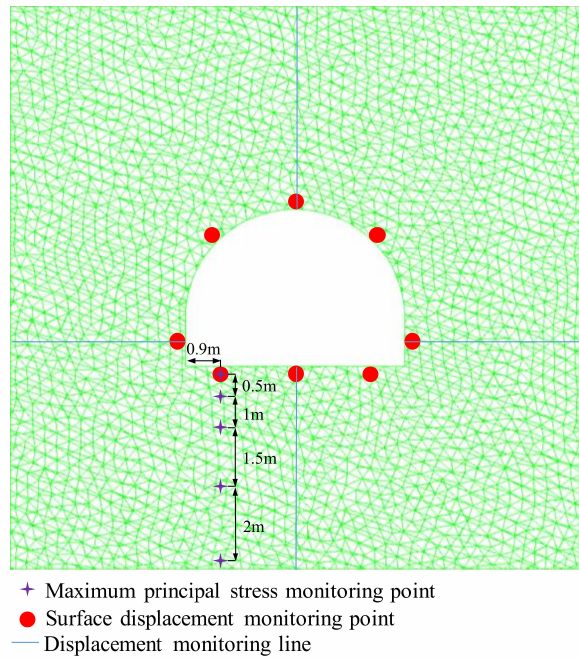
Figure 10. The location of monitoring points and lines in roadway surrounding